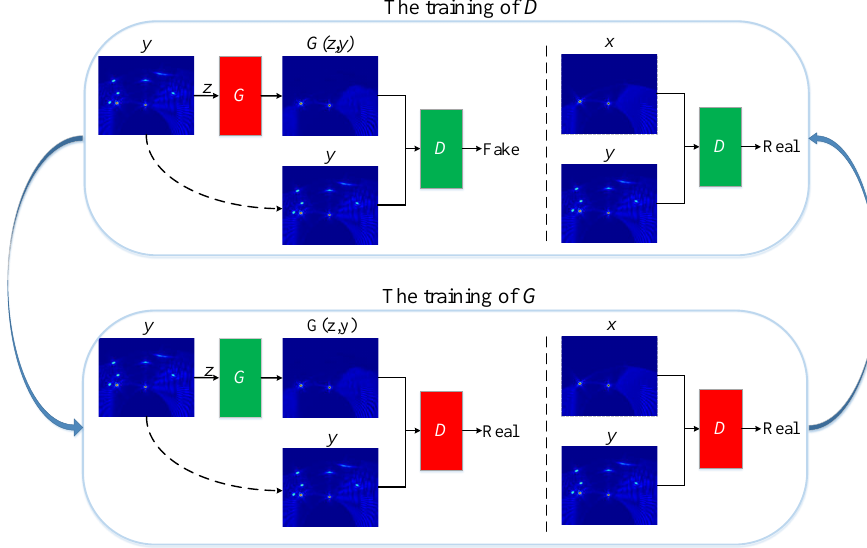
Figure 2. The training mechanism of conditional generative adversarial nets (GAN): The red rectangles indicate that the parameters of this network are fixed. The green rectangles indicate that the parameters of this network are trainable. y is the input as the control condition. x is the ground-truth